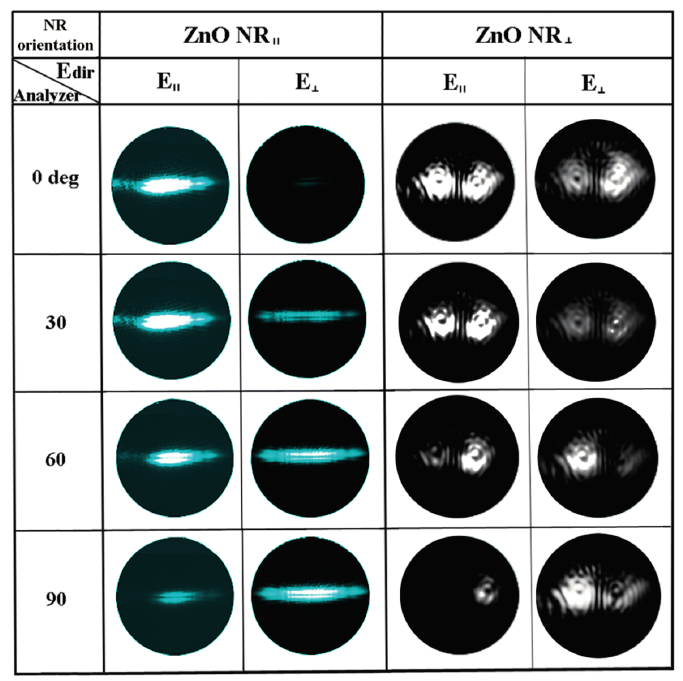
Figure 6. Back-aperture images of the scattering signal from ZnO NRs of different spatial orientations when varying the polarization direction of excitation as well as the analyzer angle. To collect the set of back-aperture images, the excitation direction of E ║ and E ┴ were used at representative collection angles of 0°, 30°, 60°, and 90°. ZnO NR ║ exhibited a linear radiation pattern rotated 90° from the physical orientation of the NR in the measurement plane. ZnO NR ┴ displayed ripple-like radiation patterns emanating from two focal points (the two scattering ends of the NR ┴ ), that mimic interference patterns seen from radially propagating waves from two different